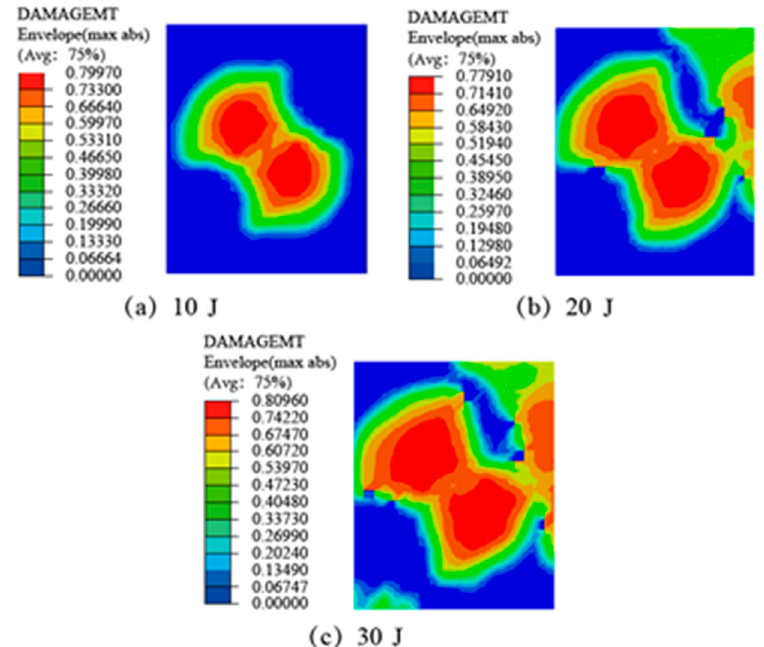
Figure 11. The matrix tensile damage of CFRP laminate SLJs at different impact energies.: ( a ) 10 J; ( b ) 20 J; ( c ) 30 J.